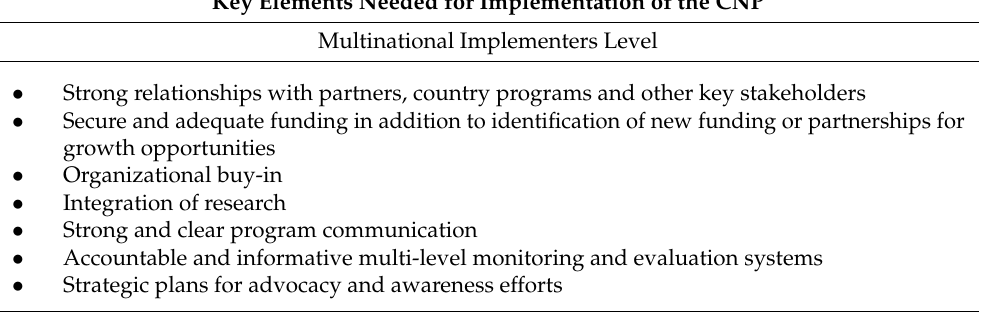
Table 3. Summary of key elements needed for program implementation at the site level, the country level and the multinational implementers level identified from the